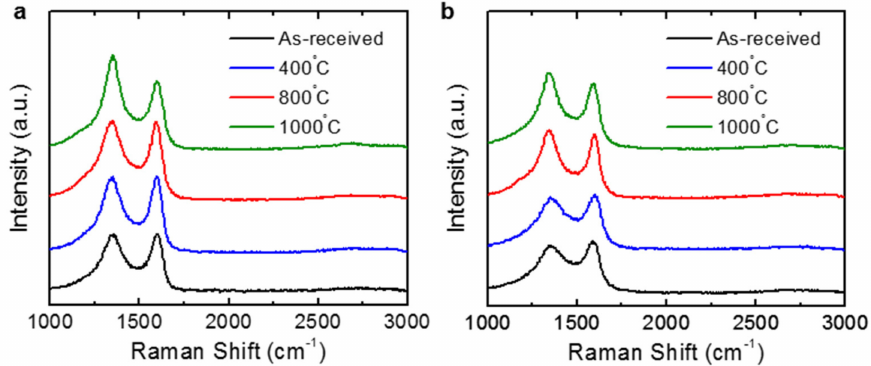
Figure 6. Raman spectra of the ( a ) TGF600 and ( b ) V-50 rGO powders as a function of the annealing